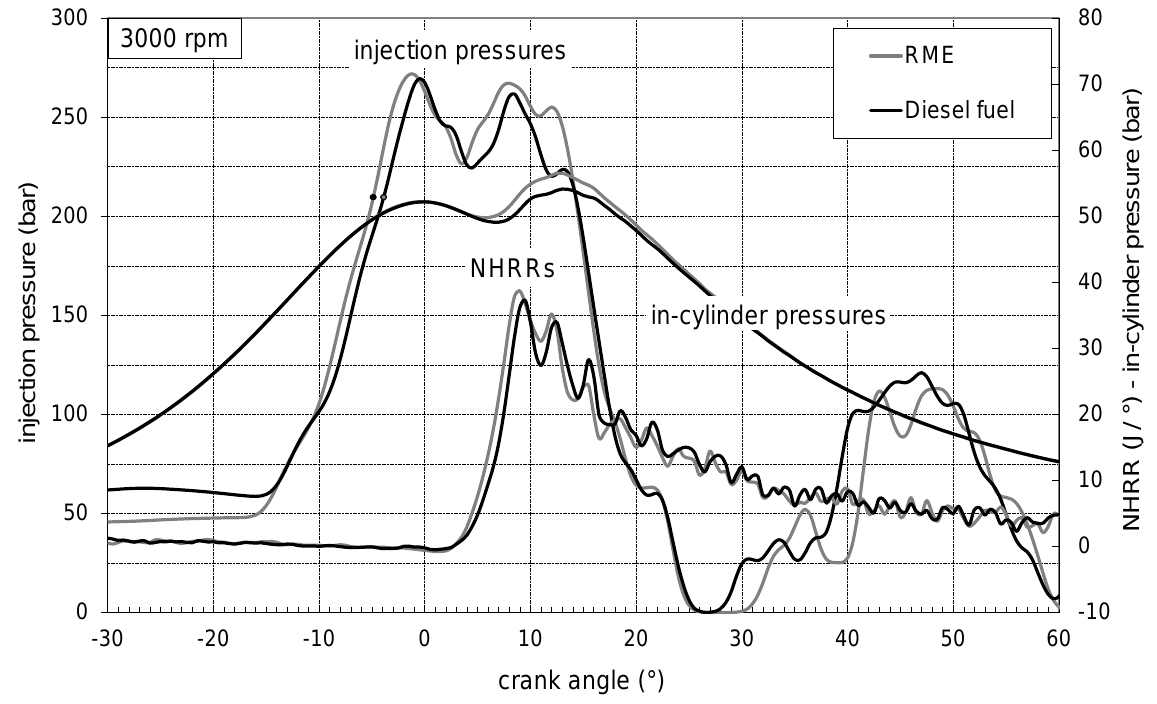
Figure 11. RME and diesel fuel injection pressures, in-cylinder pressures, and NHRR at 3000 rpm and at full load.